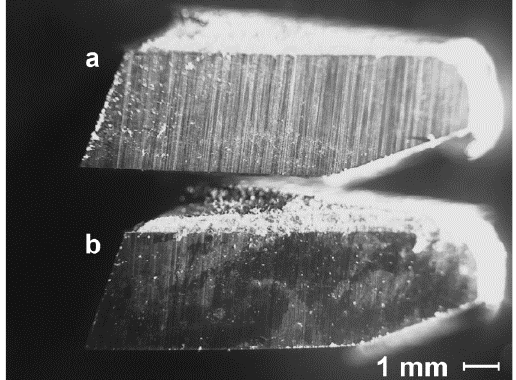
Figure 11. Tooth surfaces of circular saw blades: ( a ) non-treated tool with visible directional grinding after tool sharpening, ( b ) ion-implanted tool with poorly visible grinding obscured by a darker secondary structure.